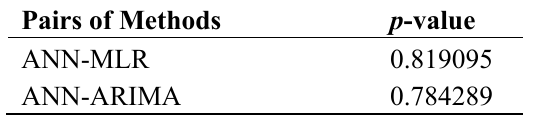
Table 6. Wilcoxson signed-rank test for each pair of forecasting methods.